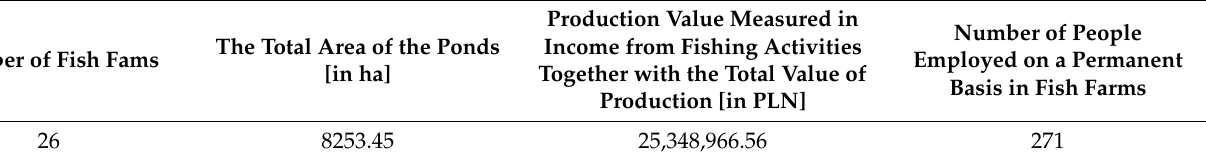
Table 5. Fish farms in the Barycz Valley.